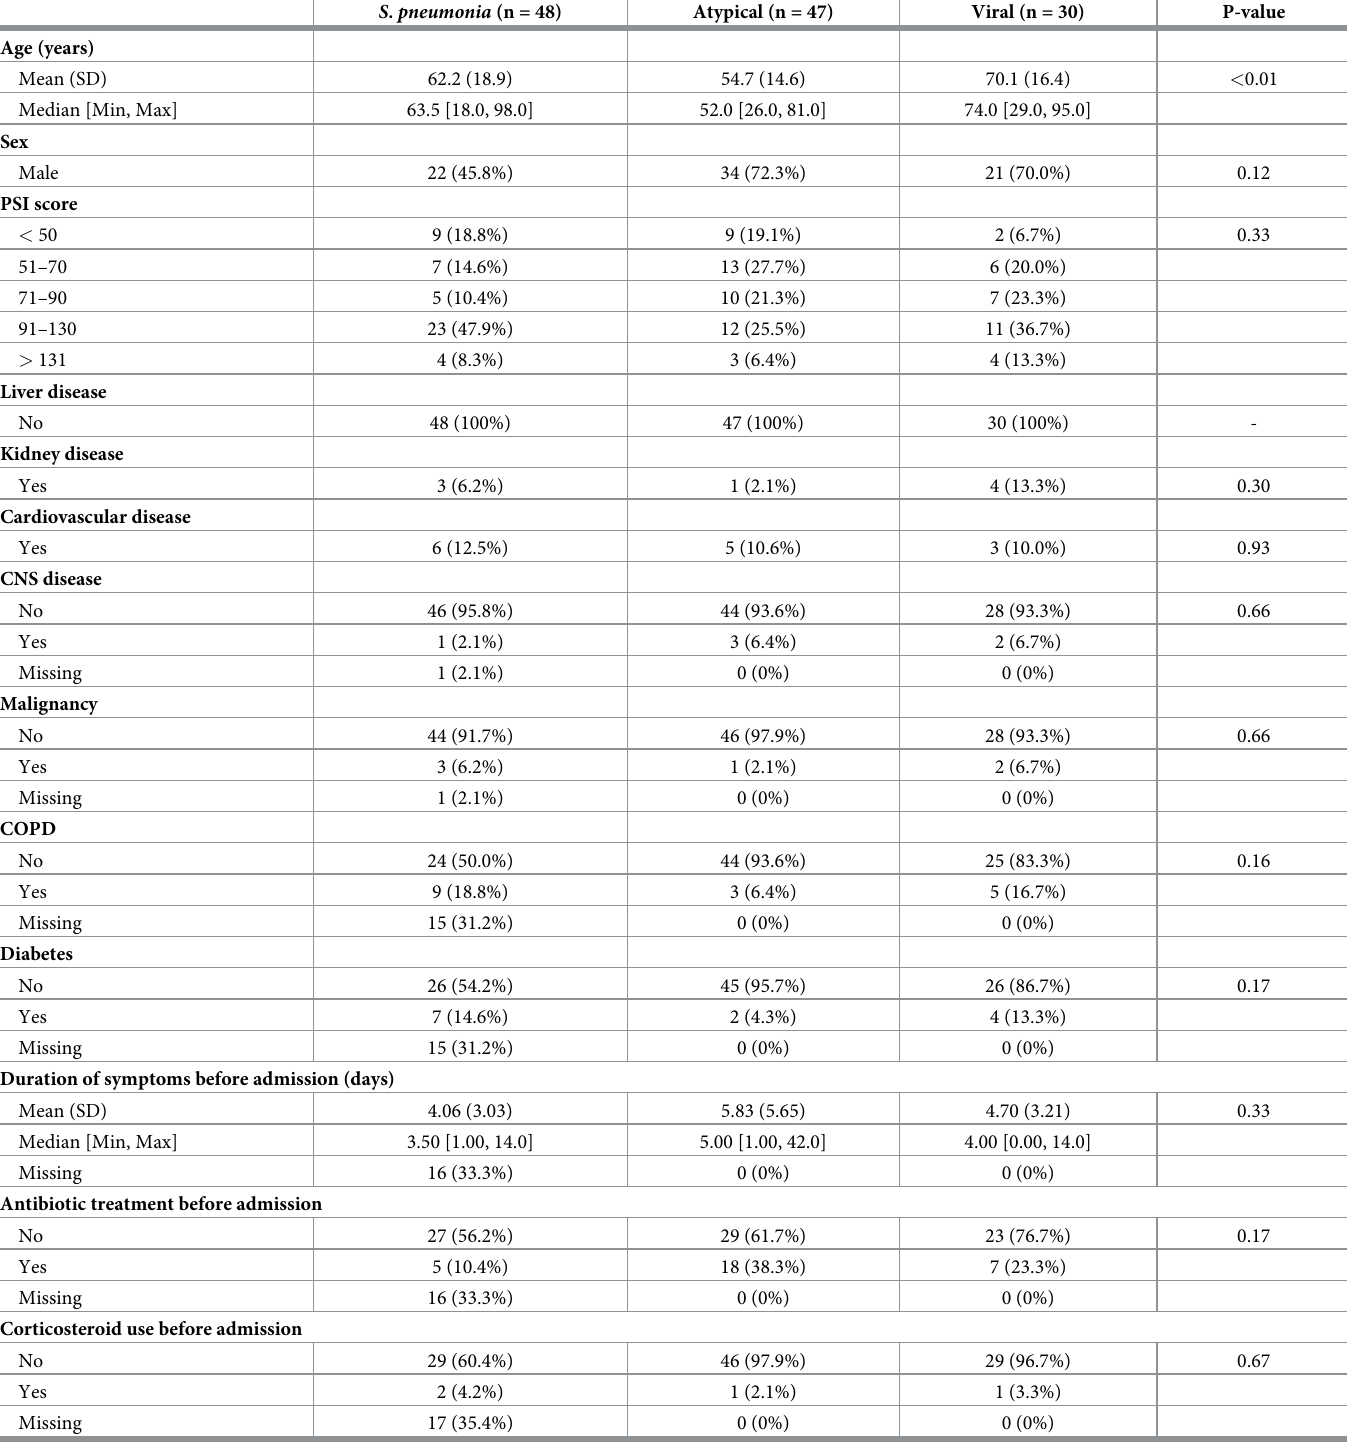
Table 1. Patient characteristics per pathogen